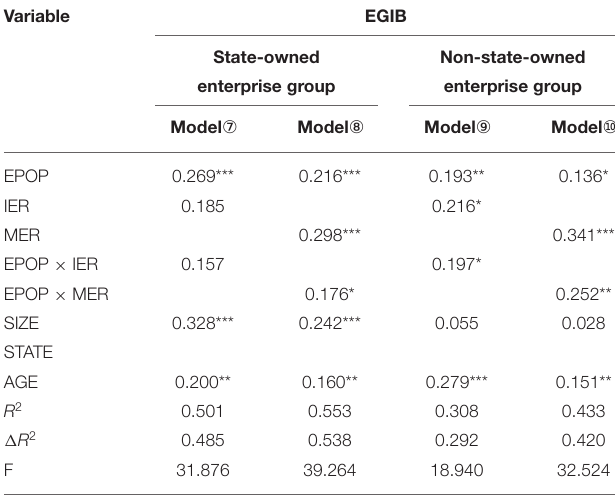
TABLE 6 | Equity heterogeneity test of moderating